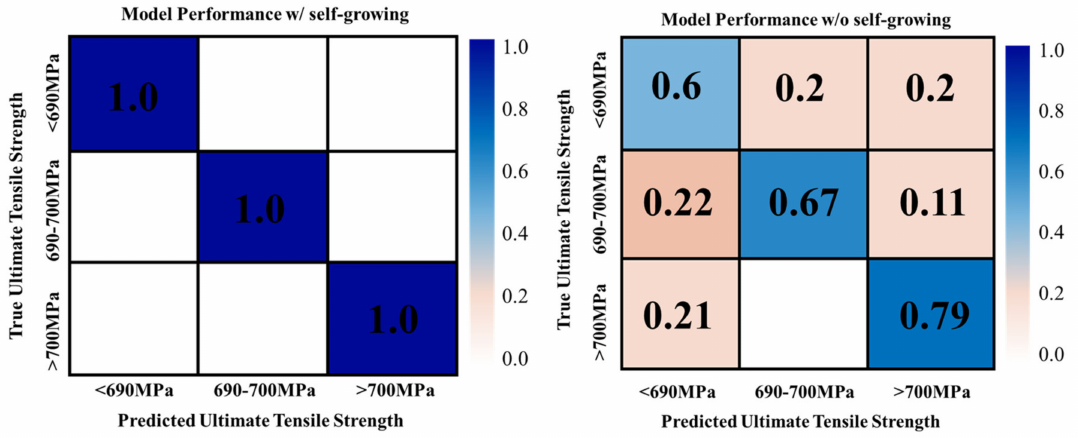
Figure 7. Machine Learning Models